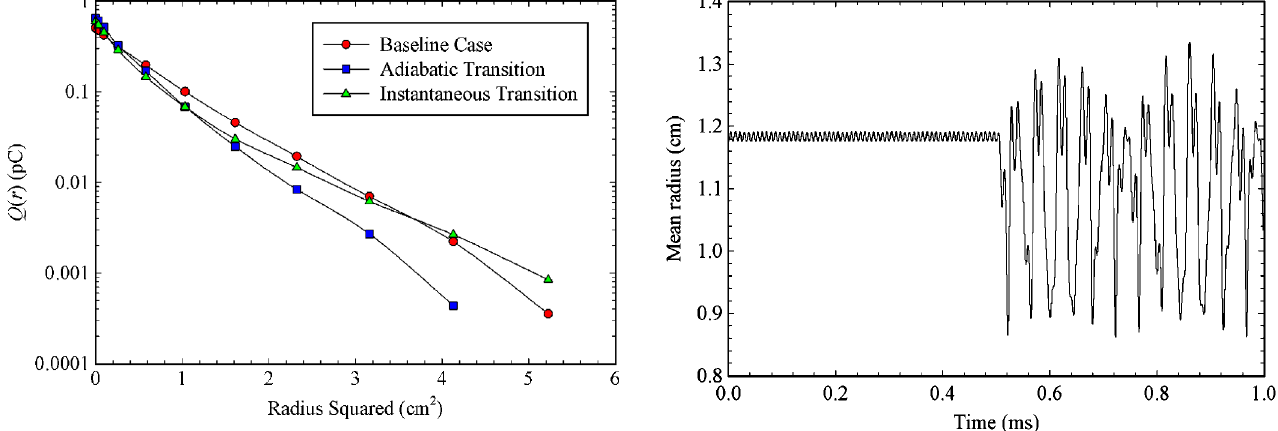
FIG. 5. (Color) The average radial density profile plotted versus r 2 is linear when the density profile is Gaussian. Both the baseline case and the adiabatically compressed case have radial density profiles that are Gaussian. In contrast, the instantane- ously compressed case has a radial density profile in which some particles have been transferred to a larger radius, thereby pro- ducing a super-Gaussian tail.